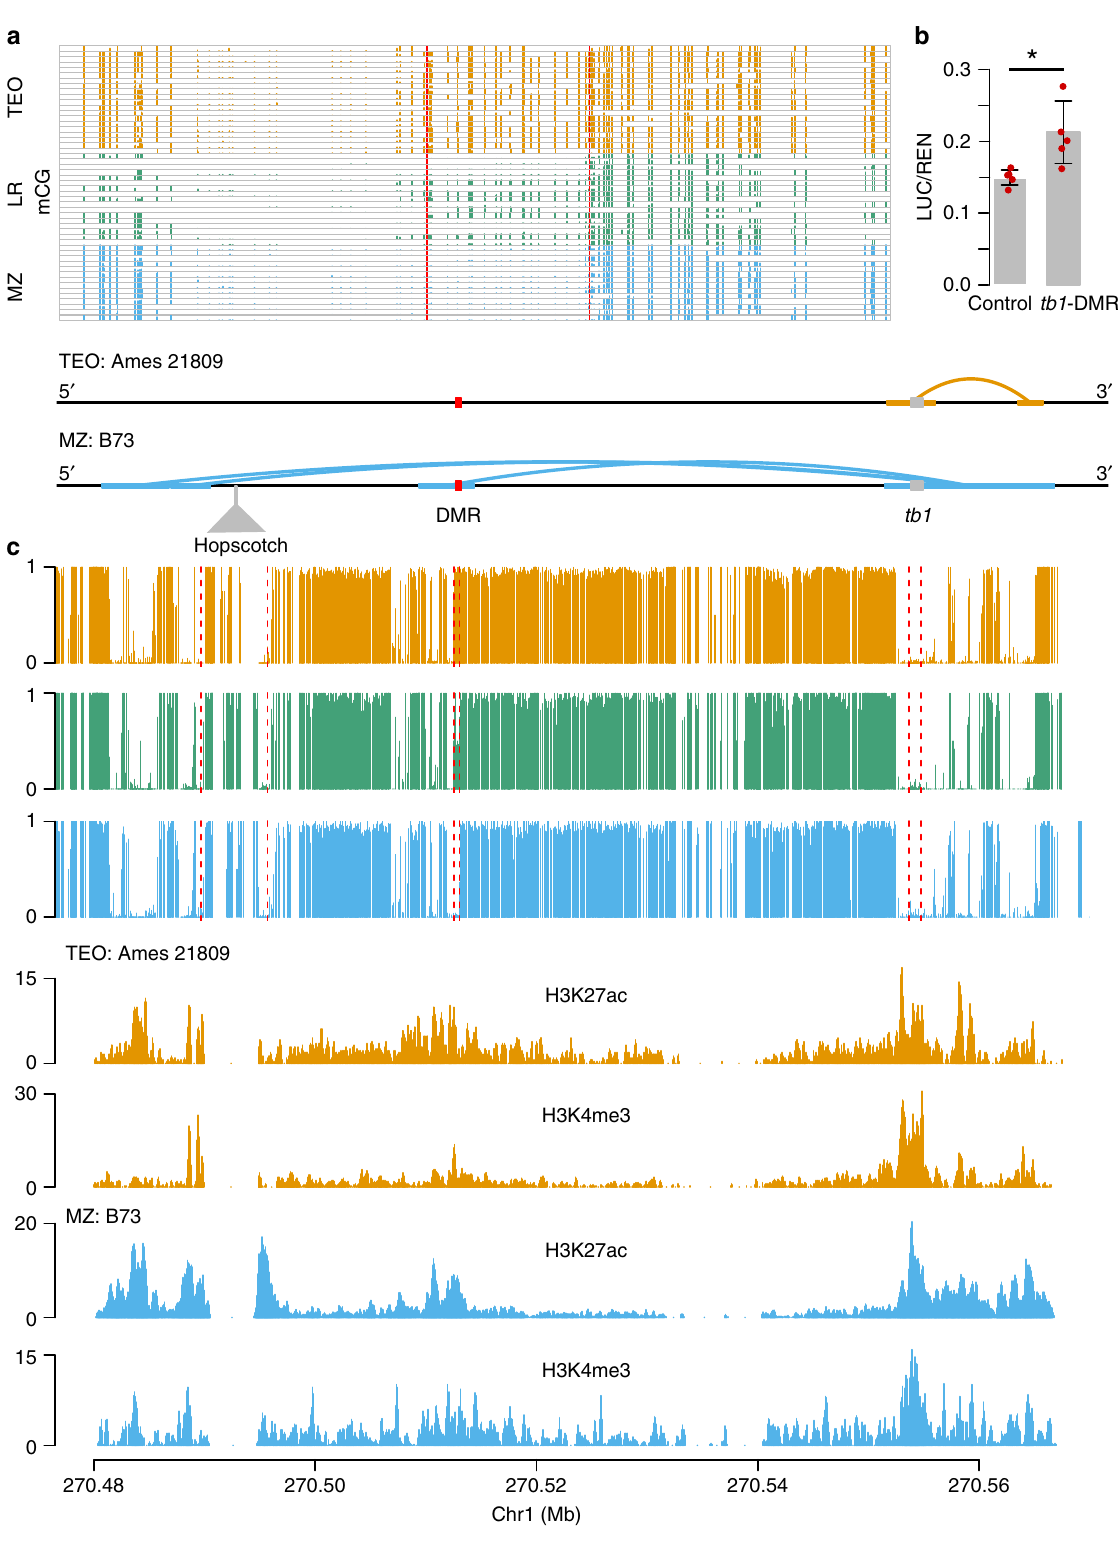
Fig. 5 A hypomethylated differentially methylated region that is upstream of tb1 gene. a Levels of mCG for the 534-bp tb1 -DMR in each individual methylome of the modern maize (MZ), landrace (LR), and teosinte (TEO) populations. Vertical red lines indicate the boundaries of the tb1 -DMR. b Interactive contacts (upper panel), average CG methylation levels (middle panel), and colocalization of the tb1 -DMR with H3K27ac and H3K4me3 (lower panel). Horizontal thick lines denote the interactive anchors and solid curly lines on top of the annotations denote the interactive contacts in teosinte and maize. c Functional validation result of tb1 -DMR using dual-luciferase transient expression assay in maize protoplasts. N = 5 biological replicates were performed. Error bars indicated SDs. Statistical signi fi cance was determined by a two-sided t -test (* P -value = 3.4 × 10 − 2 ). Source data underlying a , c are provided as a Source Data fi